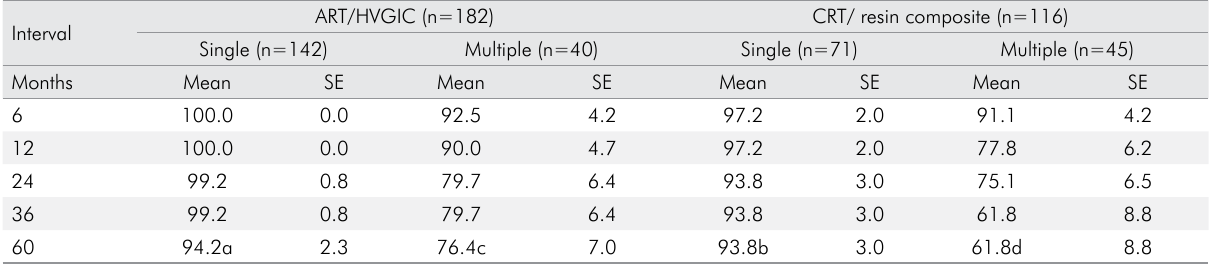
Table 2. Cumulative survival percentages and Jackknife standard error (SE) of all ART/HVGIC and CRT/resin composite restorations by type of surface.